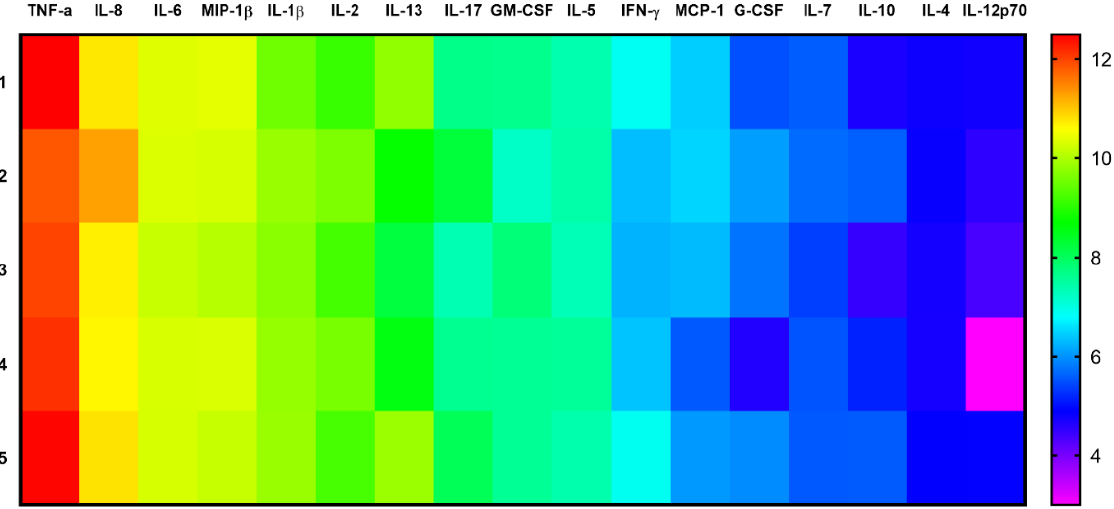
Figure 7. Percentage of “classical” Th17 (CCR4+CXCR3-) and Th17.1 (CCR4-CXCR3+) from CD4+CCR6+ cells in T helper cultures supplemented with PEGylated GO particles in two concentrations. Note: the x -axis indicates the type and concentration of nanoparticles; the y -axis is the percentage of cells. Control—culture without GO. Data are presented as median (Me) and quartiles (Q1–Q3).